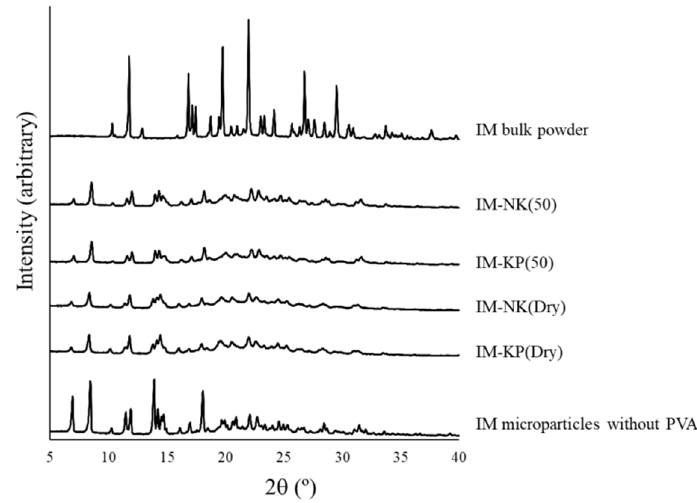
Figure 5. XRPD Patterns of IM Microparticles.